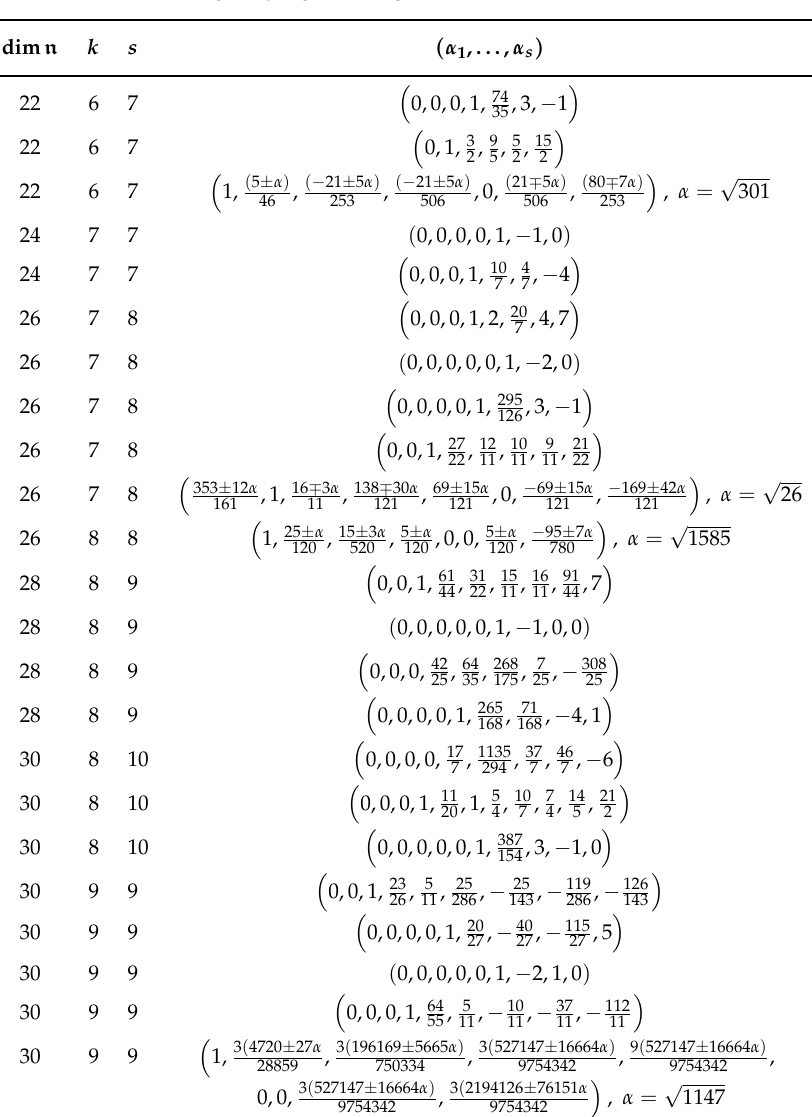
Table 1. Cohomologically rigid Lie algebras in dimensions n ≤ 30 for k ≥